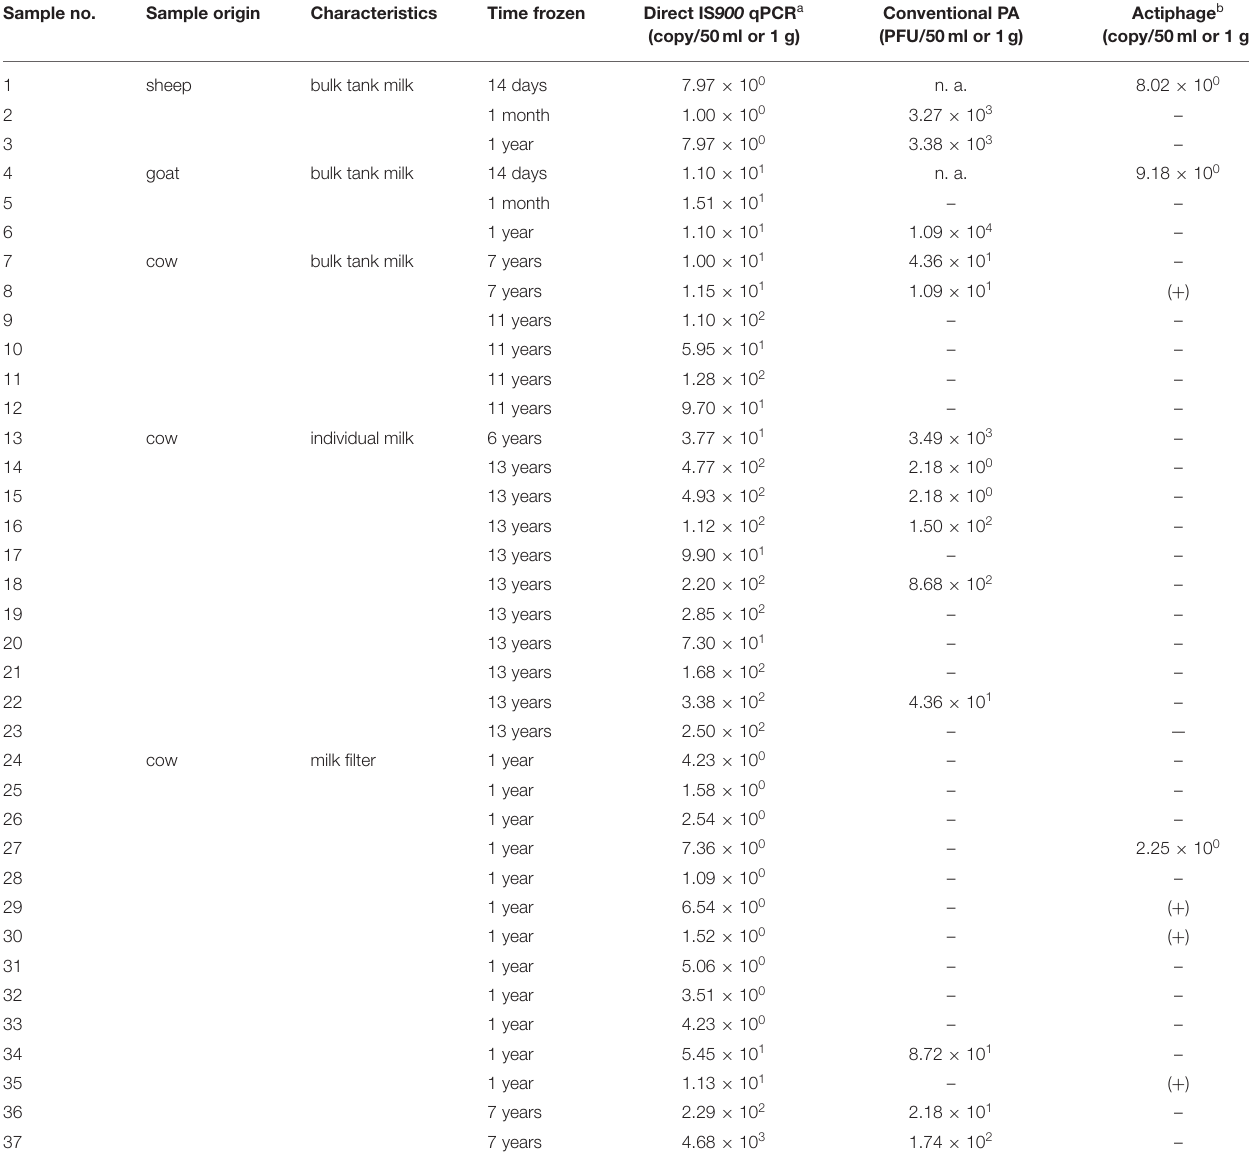
TABLE 3 | Evaluation of Actiphage-qPCR performance on naturally contaminated milk-based samples frozen for different time periods. Sample